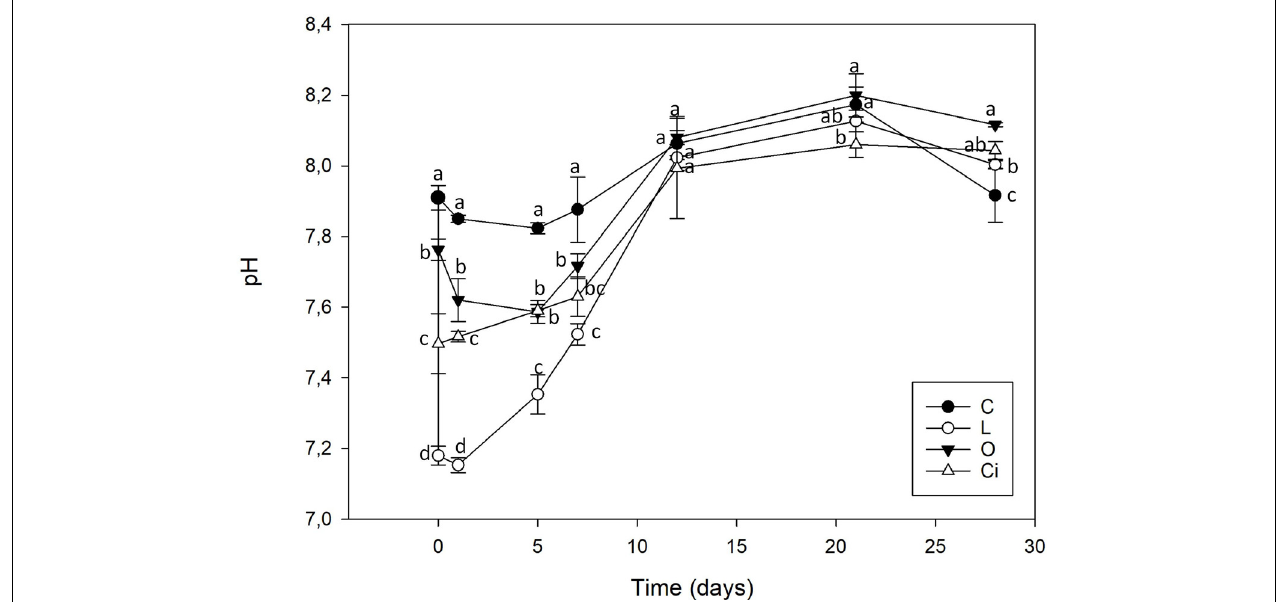
FIGURE 2 | Organic acids content of soil. L, lactic acid treated sample; O, oxalic acid treated sample; Ci, citric acid treated sample. Different letters indicate significant difference among treatments ( p < 0.05).